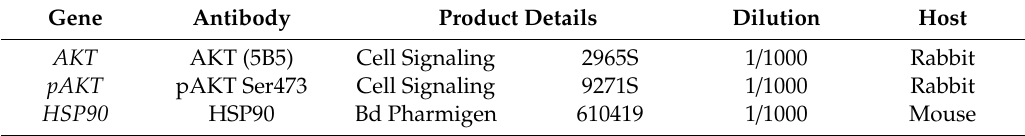
Table A4. List of antibodies used for AKT phosphorylation